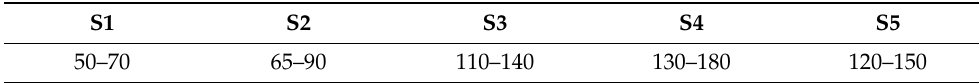
Figure 5. TG curves of obtained samples. 3.3. Kinetics of Dye’s Absorption Studies of photocatalysis were carried out with the dark phase to determine the role of the sorption stage in the process of photocatalysis. The kinetic curves for the three dyes